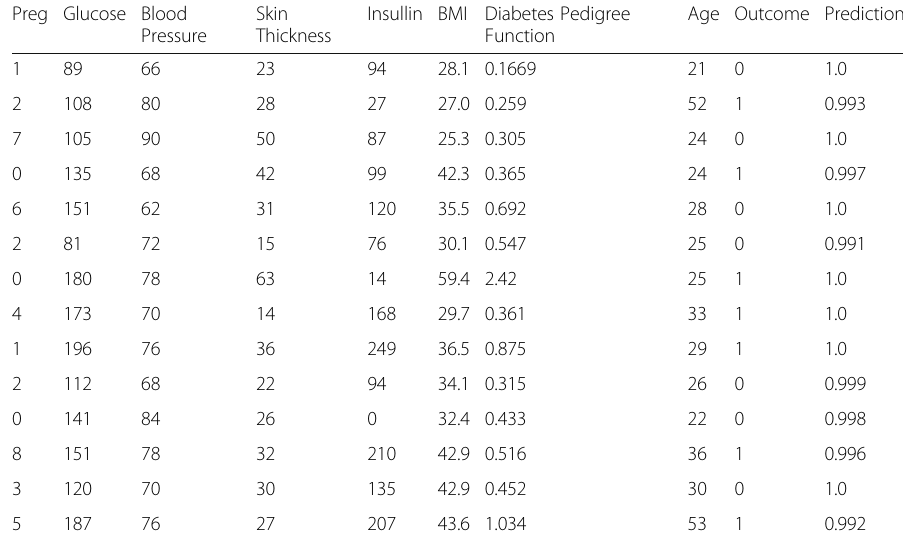
Table 7 Prediction results for the Pima Indians dataset Preg Glucose Blood